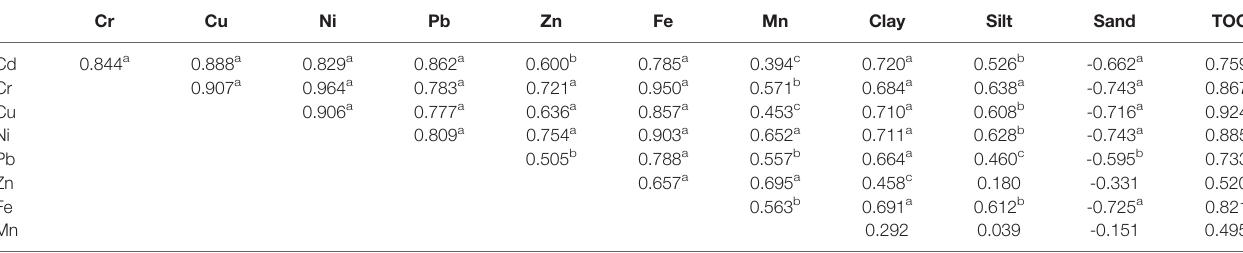
TABLE 4 | Pearson correlation analysis for total concentrations of metals and related parameters (n = 28).